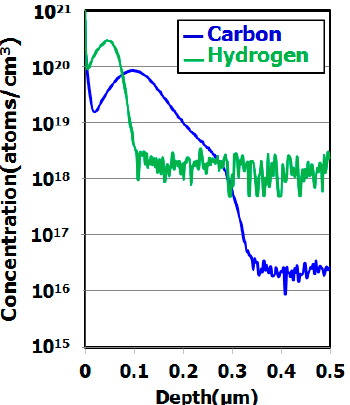
Figure 3. SIMS depth profile of hydrocarbon–molecular–ion–implanted silicon wafers [29]. Copyright (2016) The Japan Society of Applied Physics.